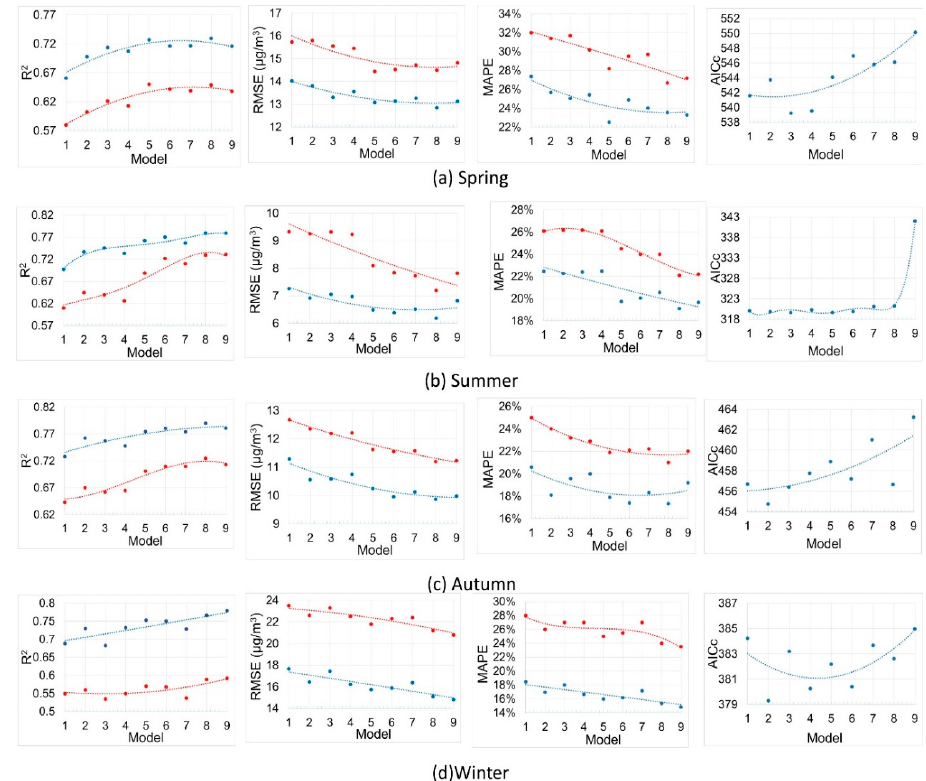
Figure 4. ( a – d ) The comparison of all seasonal GWR models with different auxiliary variables. Blue scattering points are quantitative measures (R 2 , RMSE, MAPE and AICc) of model fitting and red points are those of model evaluation. The dash lines are fitted curves of all scattered points in different seasons.